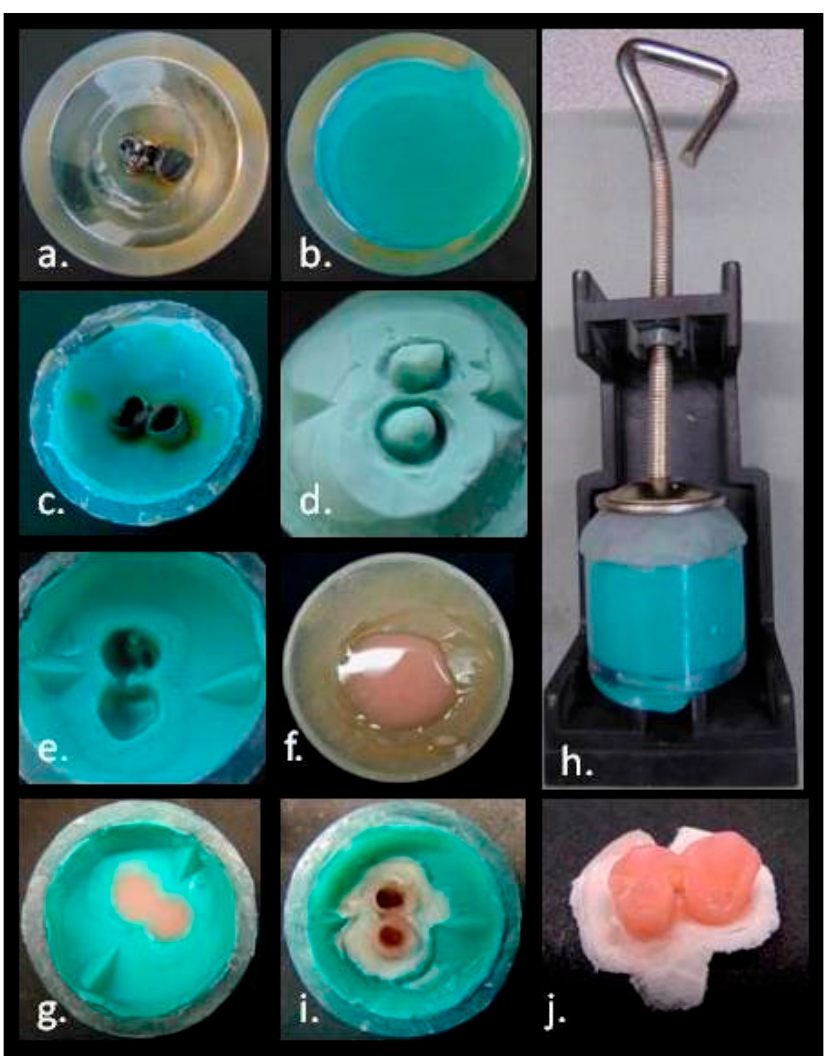
Figure 4. ( a ). Preparation of the P framework in the cylindrical shaper; ( b ). The silicone material into the conformer, over framework P; ( c ). Framework P from the duplicating mold; ( d ). Mold for the internal shape of the model; ( e ). Mold for the external shape of the model; ( f ). Preparation of the resin material in the plastic phase; ( g ). Material into the mold; ( h ). Mold mounting in a mechanical press system by screw; ( i ). Framework after the setting of the layout material; ( j ). Framework with press burrs.